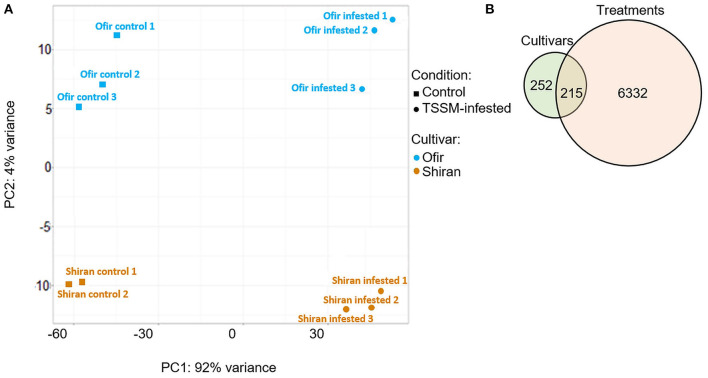
Transcriptomic overview of two tomato cultivars infested with TSSMs for 3 days. (A) PCA plot was generated using 22,592 genes (transcripts with only zero values were excluded). (B) Venn diagram illustrates the number of genes that were differentially expressed (DEGs) between the two cultivars (Shiran/Ofir) and/or treatments (TSSM-infested/control). Absolute fold change >|2|, p < 0.05 FDR (n = 5–6 biological replicates).